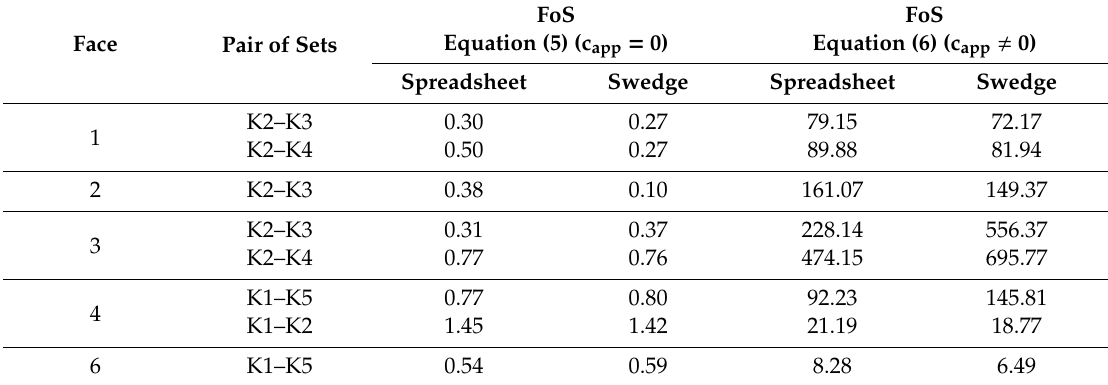
Table 7. Summary of results in terms of FoS with respect to wedge sliding mechanism for excavation faces from 1 to 7.